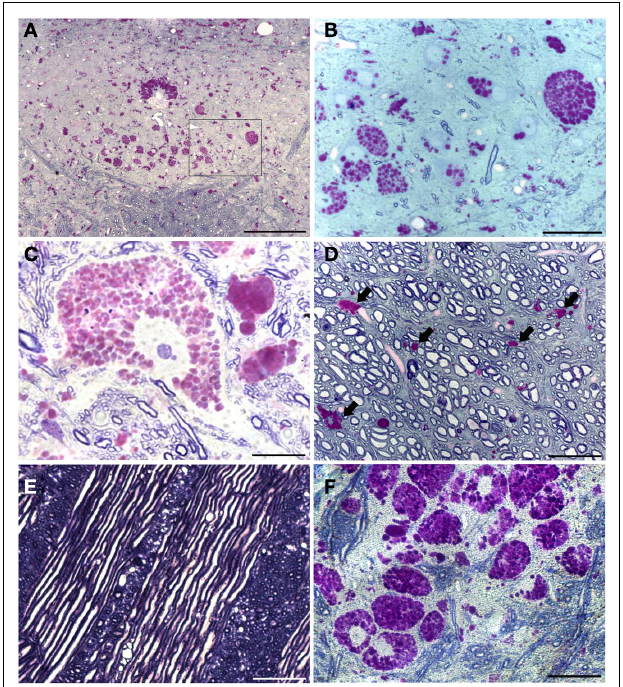
FIGURE 2 | Plastic-embedded semi-thin medullary sections (2 μ m) show neuronal glycogen accumulation in Gaa − / − mice. Sections were stained with PAS and toluidine blue. (A) Provides a low power view including both hypoglossal nuclei; (B) is a higher resolution image of the area indicated by the box in (A) .These images demonstrate that PAS staining within the XII nuclei is restricted to neuronal cell bodies. Ependymal cells around the central canal (CC) also showed robust PAS staining (A) . (C) Shows a high magnification of PAS staining within a XII motoneuron – note the extensive accumulation of glycogen droplets in the cytoplasm with no positive nuclear staining.The image in (D) is from the ventral medulla near the pyramidal decussation. PAS positive neuroglial cells were noted (indicated by the arrows) but axons appear to be healthy with no evidence of glycogen accumulation. Similarly, glycogen accumulation was not observed in medullary axons including cranial nerve fibers (E) . Finally, (F) depicts the extensive neuronal glycogen accumulation within the nucleus ambiguous in the rostral medulla. Although not the primary focus of this work, this image is included to illustrate that neuropathology in upper airway motor systems in Gaa − / − mice is not limited to the XII motor nucleus. Scale bars: (A) : 100 μ m; (B,D–F) : 50 μ m; (C) : 20 μ m.